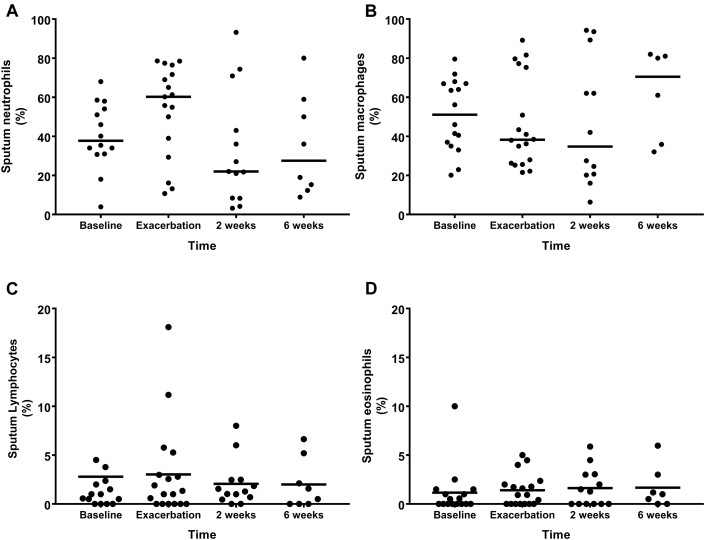
Differential cell counts in patients with naturally acquired exacerbations. A, Percentage of neutrophils in sputum. B, Percentage of macrophages in sputum. C, Percentage of lymphocytes in sputum. D, Percentage of eosinophils in sputum.